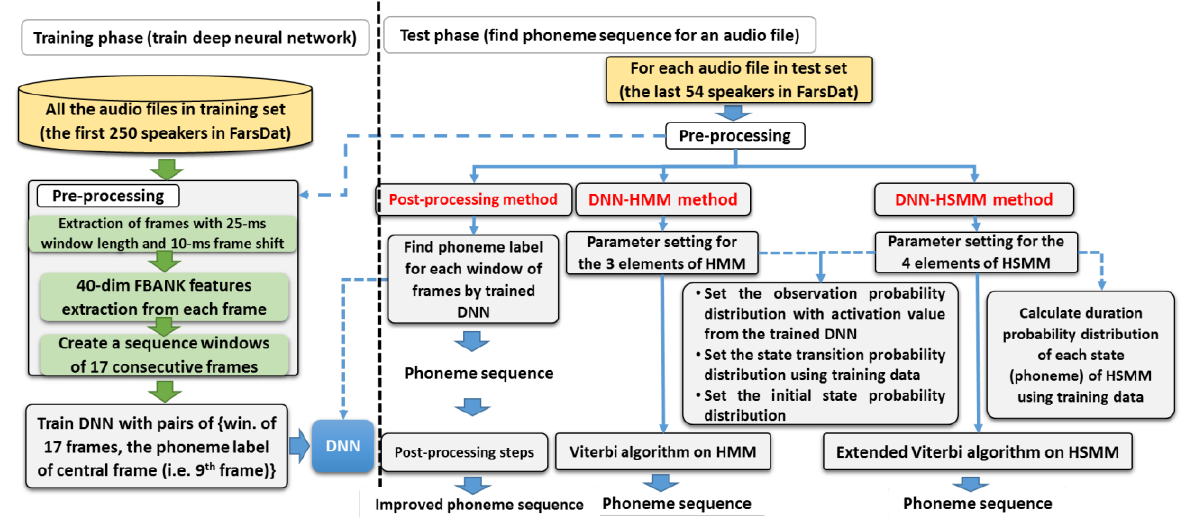
Figure 1. Block diagram for the proposed train and test